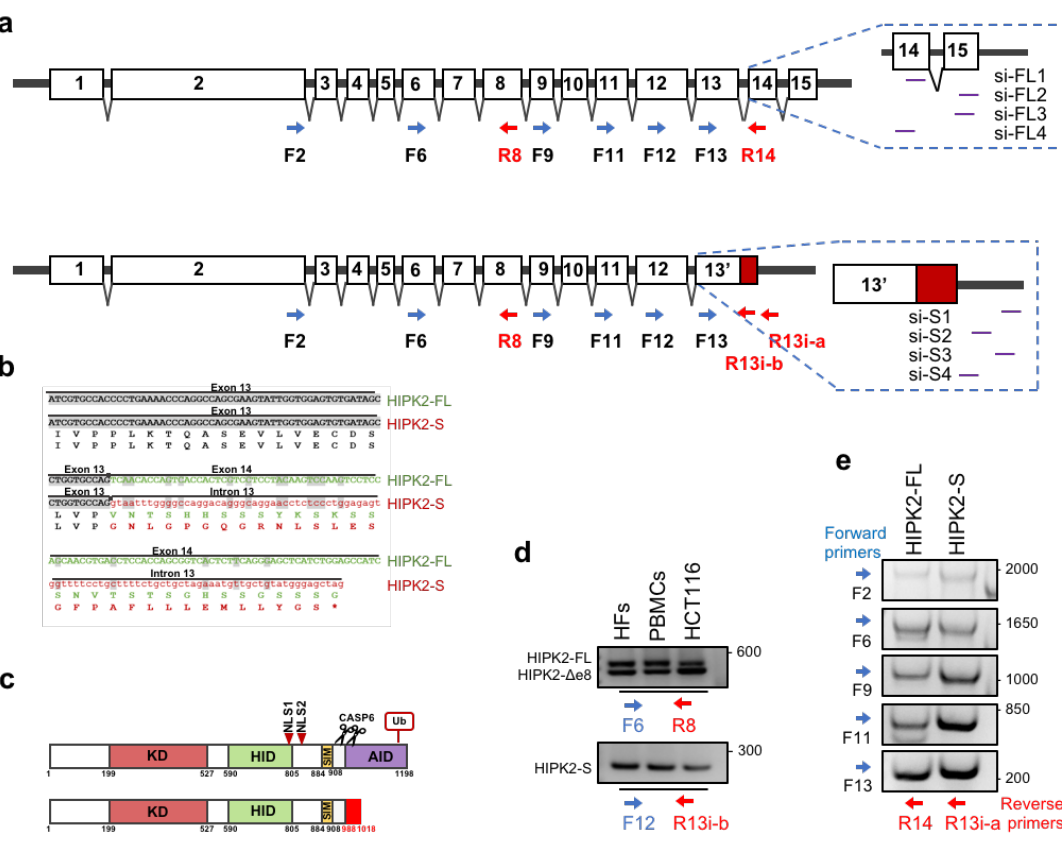
Figure 1. Identification of a new alternative splice variant of HIPK2. ( a ) Schematic representation of the exon composition of HIPK2-FL (upper) and HIPK2-S (lower) isoforms. In red is depicted the HIPK2-S specific sequence that is translated. In the enlarged boxes are indicated the annealing localizations of specific forward (F) and reverse (R) PCR primers and si-S and si-FL siRNAs. ( b ) Sequence alignment and relative translation of HIPK2-FL and HIPK2-S mRNA sequences. In light gray is highlighted the sequence common to both isoforms while the HIPK2-FL and HIPK2-S specific sequences are indicated in green and red, respectively. ( c ) Schematic illustration of HIPK2-FL and HIPK2-S protein isoforms specifying protein domain organization. KD: Kinase Domain; HID: Homeodomain Interacting Domain; NLS: Nuclear Localization Signal; SIM: Sumo Interacting Motif; CASP6: Caspase 6 cleavage sites; AID: Autoinhibitory Domain; Ub: Ubiquitination site. ( d ) RT-PCR using the indicated forward and reverse primers showed the presence of HIPK2-FL and HIPK2- ∆ e8 (upper panel) and HIPK2-S (lower panel) in di ff erent human cell types. ( e ) Di ff erent RT-PCRs were performed using the indicated combination of forward and reverse primers. In particular, the reverse primer R14 anneals on exon14 and amplifies HIPK2-FL (left lane) and the reverse primer R13i anneals on intron13 and amplifies HIPK2-S (right lane). As forward primers were used oligonucleotides annealing to exons from 13 (lower panel) to 2 (upper panel).